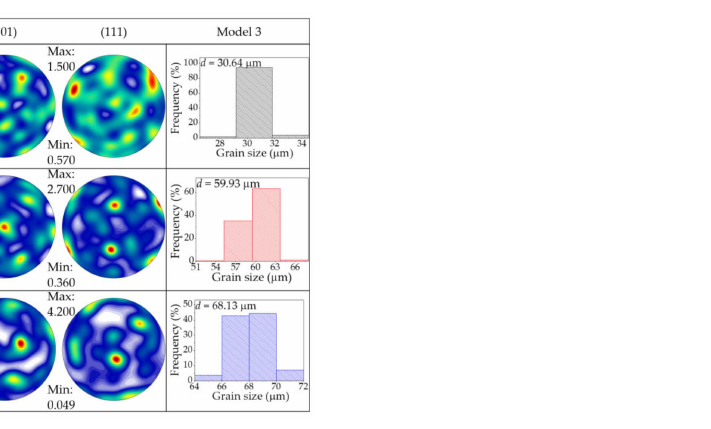
Figure 5. Crystal orientation and grain size distribution: ( a ) model 1; ( b ) model 2; ( c ) model 3.